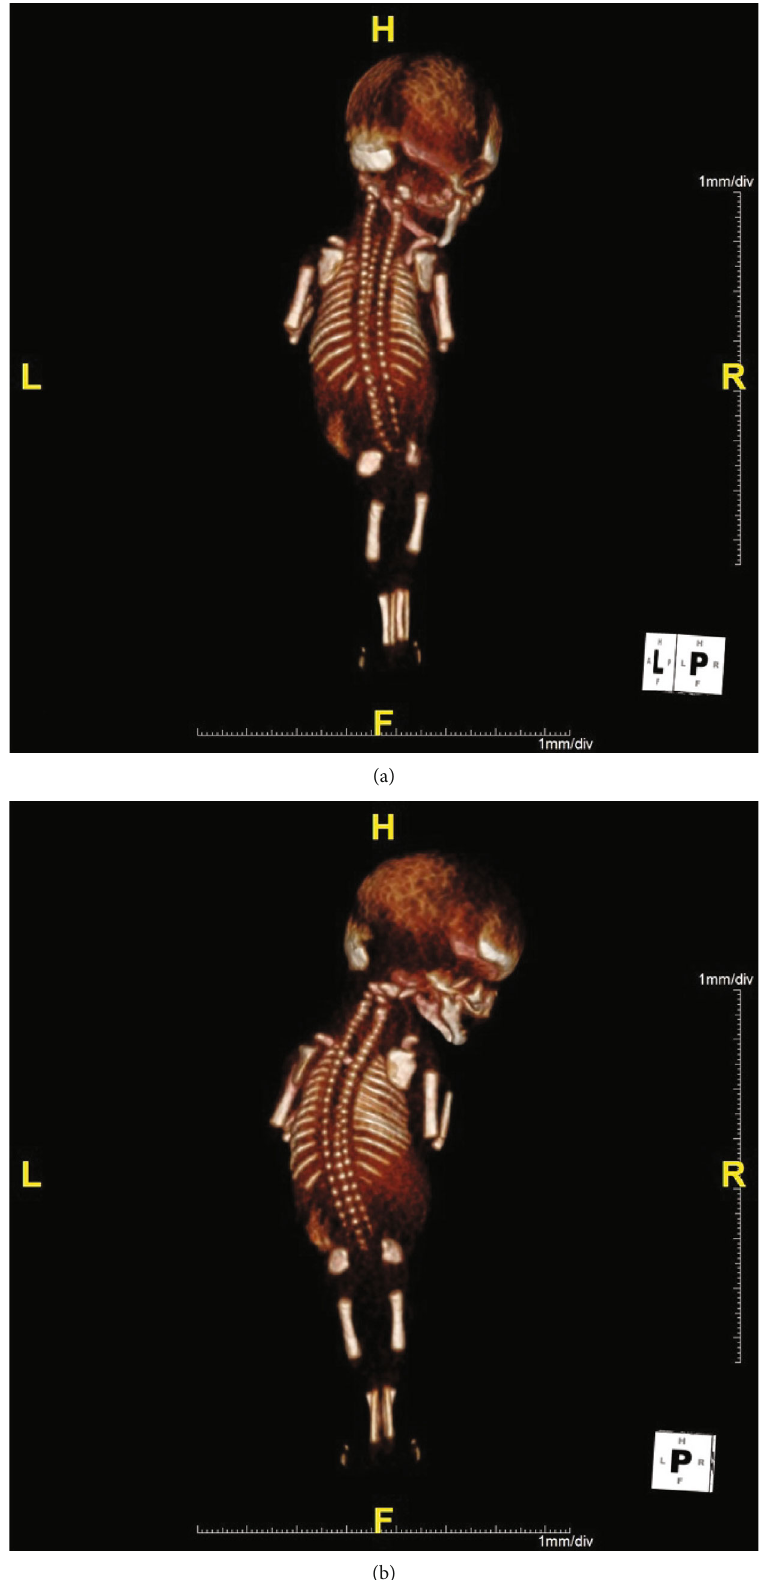
Figure 5: Postmortem CT images of the delivered baby. Two femurs, two tibiae, and two fi bulae were contained in the single lower limb, and none of them was fused (a). Agenesis of lower lumbar and sacral spines was noted